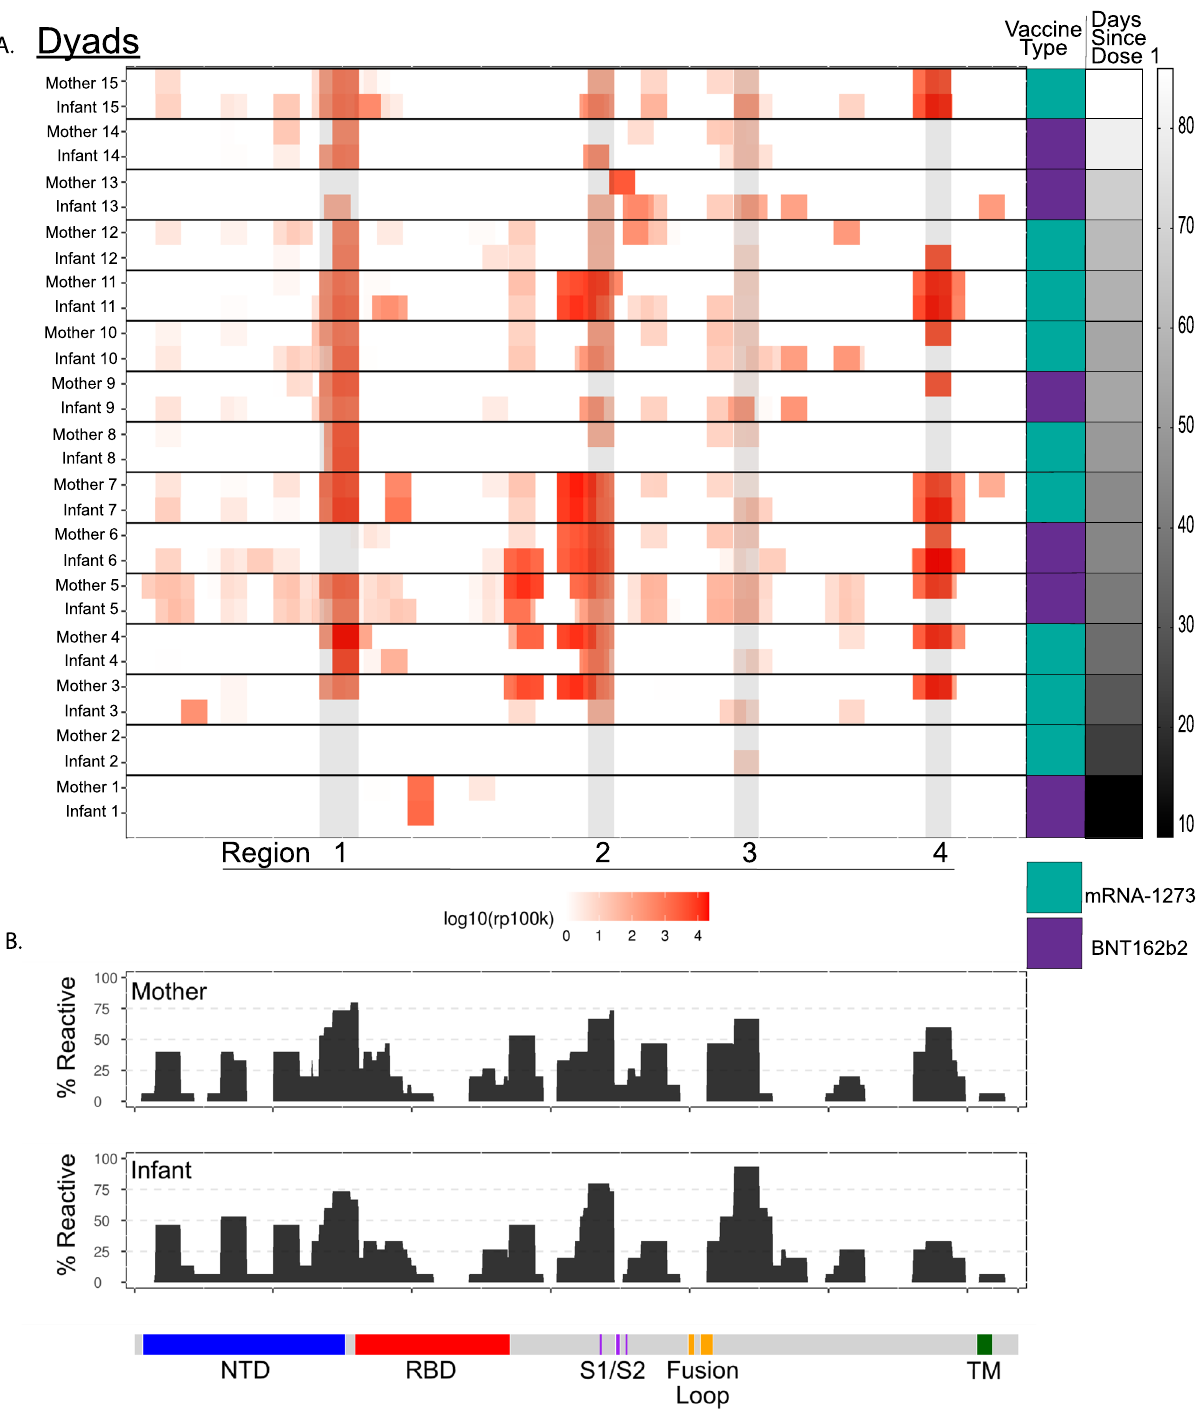
Fig. 5 | PhIP-seq/VirScan paired maternal and cord SARS-CoV-2 Spike protein epitope binding. A Heatmap displaying results of signi fi cant enriched ( p <0.001) linear SARS-CoV-2 Spike protein epitope binding from 15 paired mother-infant dyads in maternal plasma at delivery and cord plasma by vaccine type and time since vaccine dose 1. Areas of high cumulative epitope binding designated by regions1 – 4. B CumulativefoldenrichmentofmothersandinfantslinearSARS-CoV- 2 Spike protein epitope binding. Counts per 100,000 reads for all peptides